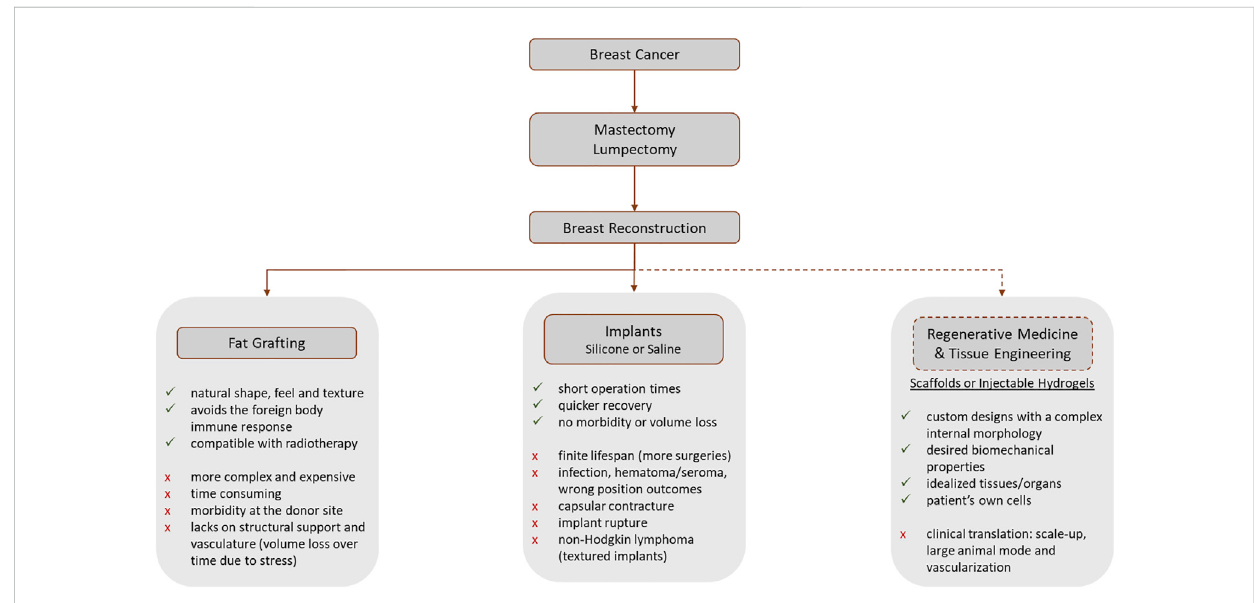
FIGURE 1 Work fl ow representing the most common post-breast cancer diagnosis steps that involve a mastectomy or lumpectomy. The advantages and disadvantages of each procedure are presented (Patrick, 2004; Combellack et al., 2016; Rocco et al., 2016; Visscher et al., 2017; O ’ Halloran N. A. et al., 2018; Chae et al., 2018; Mohseni et al., 2018; Cleversey et al., 2019; Rocco et al., 2019; Donnely et al., 2020; Janzekovic et al., 2020). The dashed line represents the research-only procedures, while the full lines represent the current clinically available